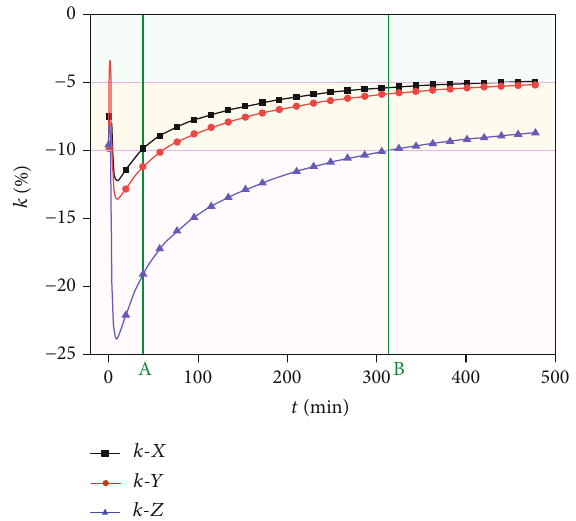
Figure 9: Di ff erence coe ffi cient of gas production under di ff erent unloading stress